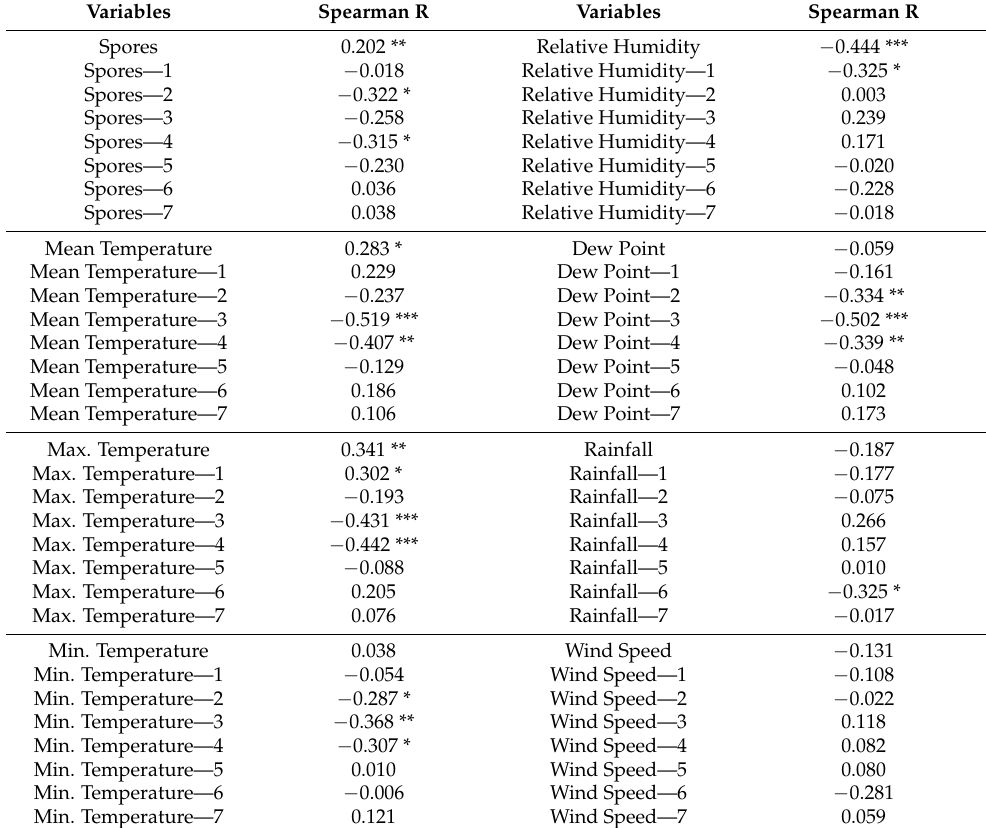
Table 4. Spearman’s correlation coefficients between airborne protein concentrations and the consid- ered aerobiological and meteorological variables.